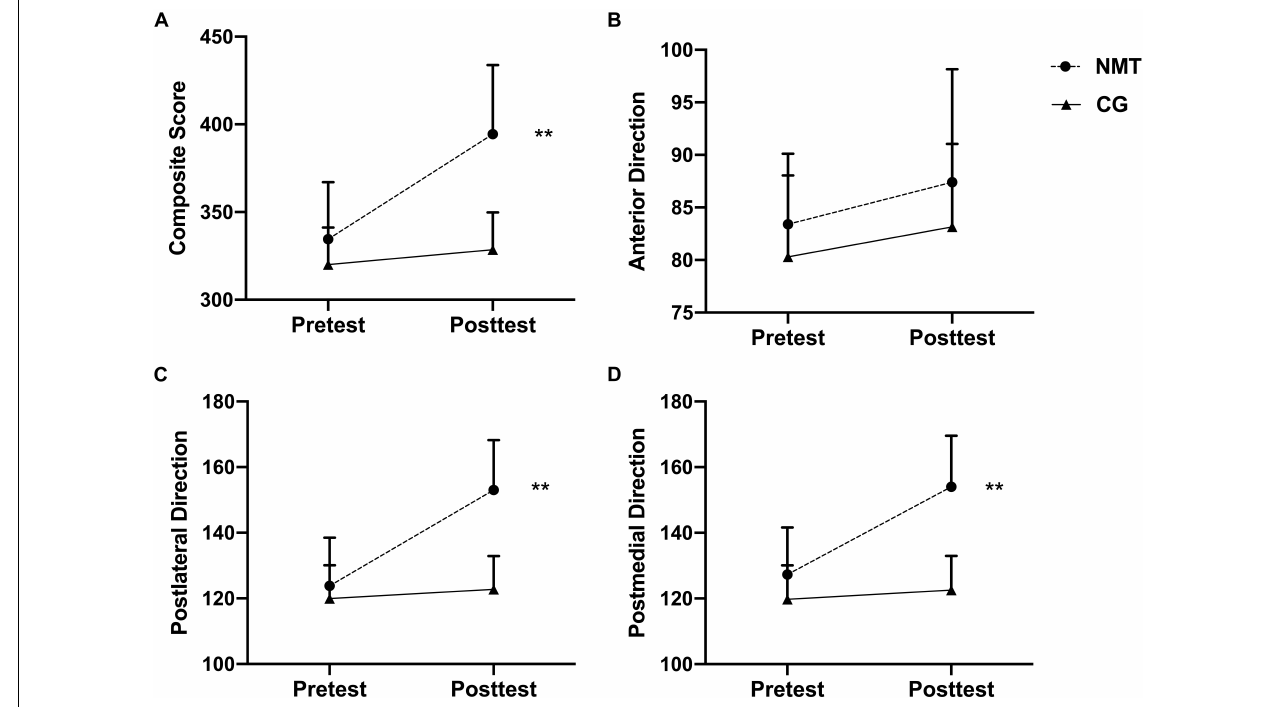
FIGURE 3 | Changes in the Composite (A) , the anterior- (B) , posterolateral- (C) , and posteromedial- (D) direction Y-balance test score on left limb in the neuromuscular training group (NMT) and the control group (CG) before and after the program (**inter group difference with p ≤